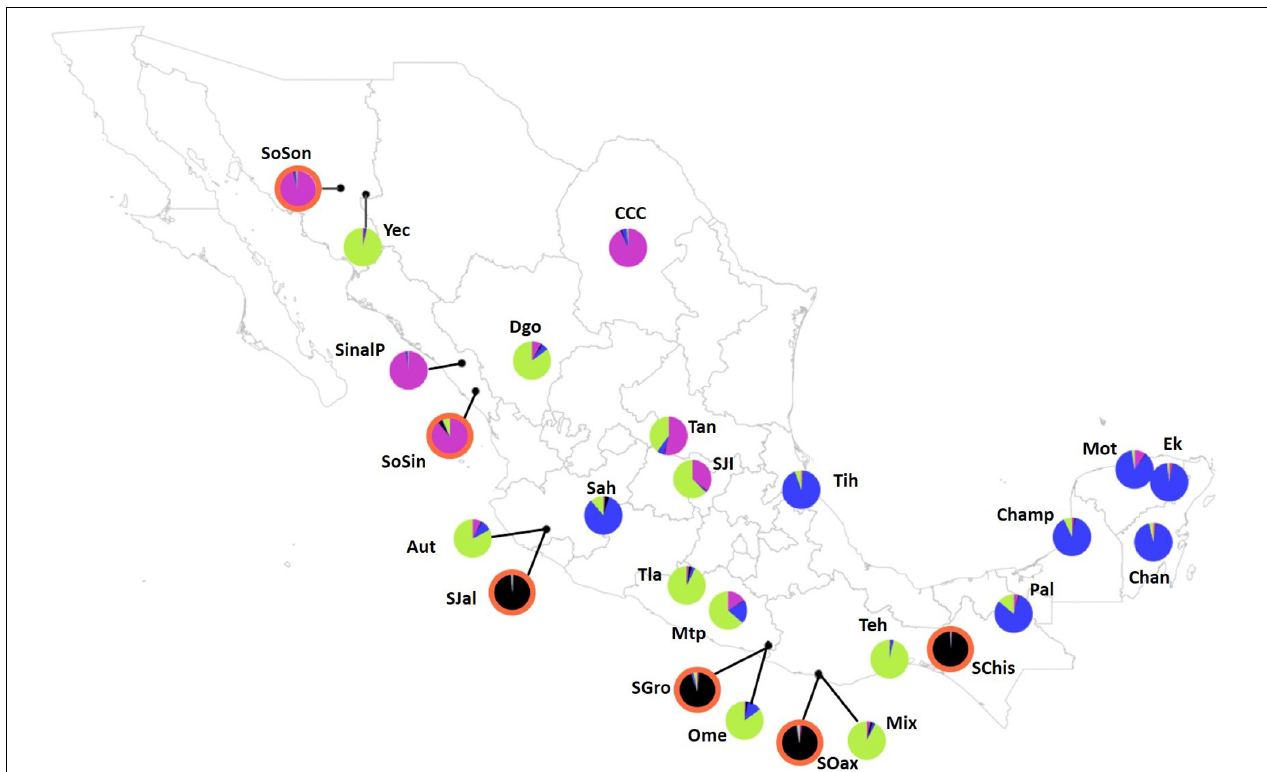
FIGURE 4 | Population map depicting pie graphs corresponding to the proportion of individuals per population assigned to each genetic cluster obtained with STRUCTURE for K = 4. Populations with graph pie outlined in orange highlight sororia populations. The black cluster consists of four sororia populations: Schis, Soax, Sgro, Sjal. The other two sororia populations (SoSin and SoSon) were assigned to a second cluster with argyrosperma populations CCC, and SinalP located in Northern Mexico (pink). The third cluster (blue) consists of populations Ek, Mot, Chan, Champ and Pal, from the Yucatan Peninsula and populations from Michoacán (Sah) and Veracruz (Tih). The fourth cluster (green) is constituted by populations Teh, Mix, Ome, Tla, Aut, and Yec, from the Pacific coast and Durango (Dgo). Population ID are as shown in Table 1